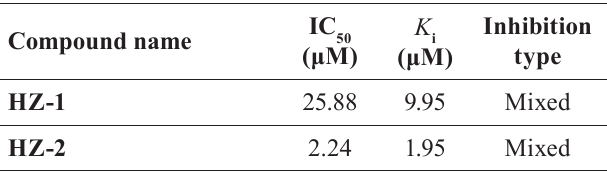
TABLE Ι - I C and K values of HZ-1 and HZ-2 against GUS 50 i Compound name